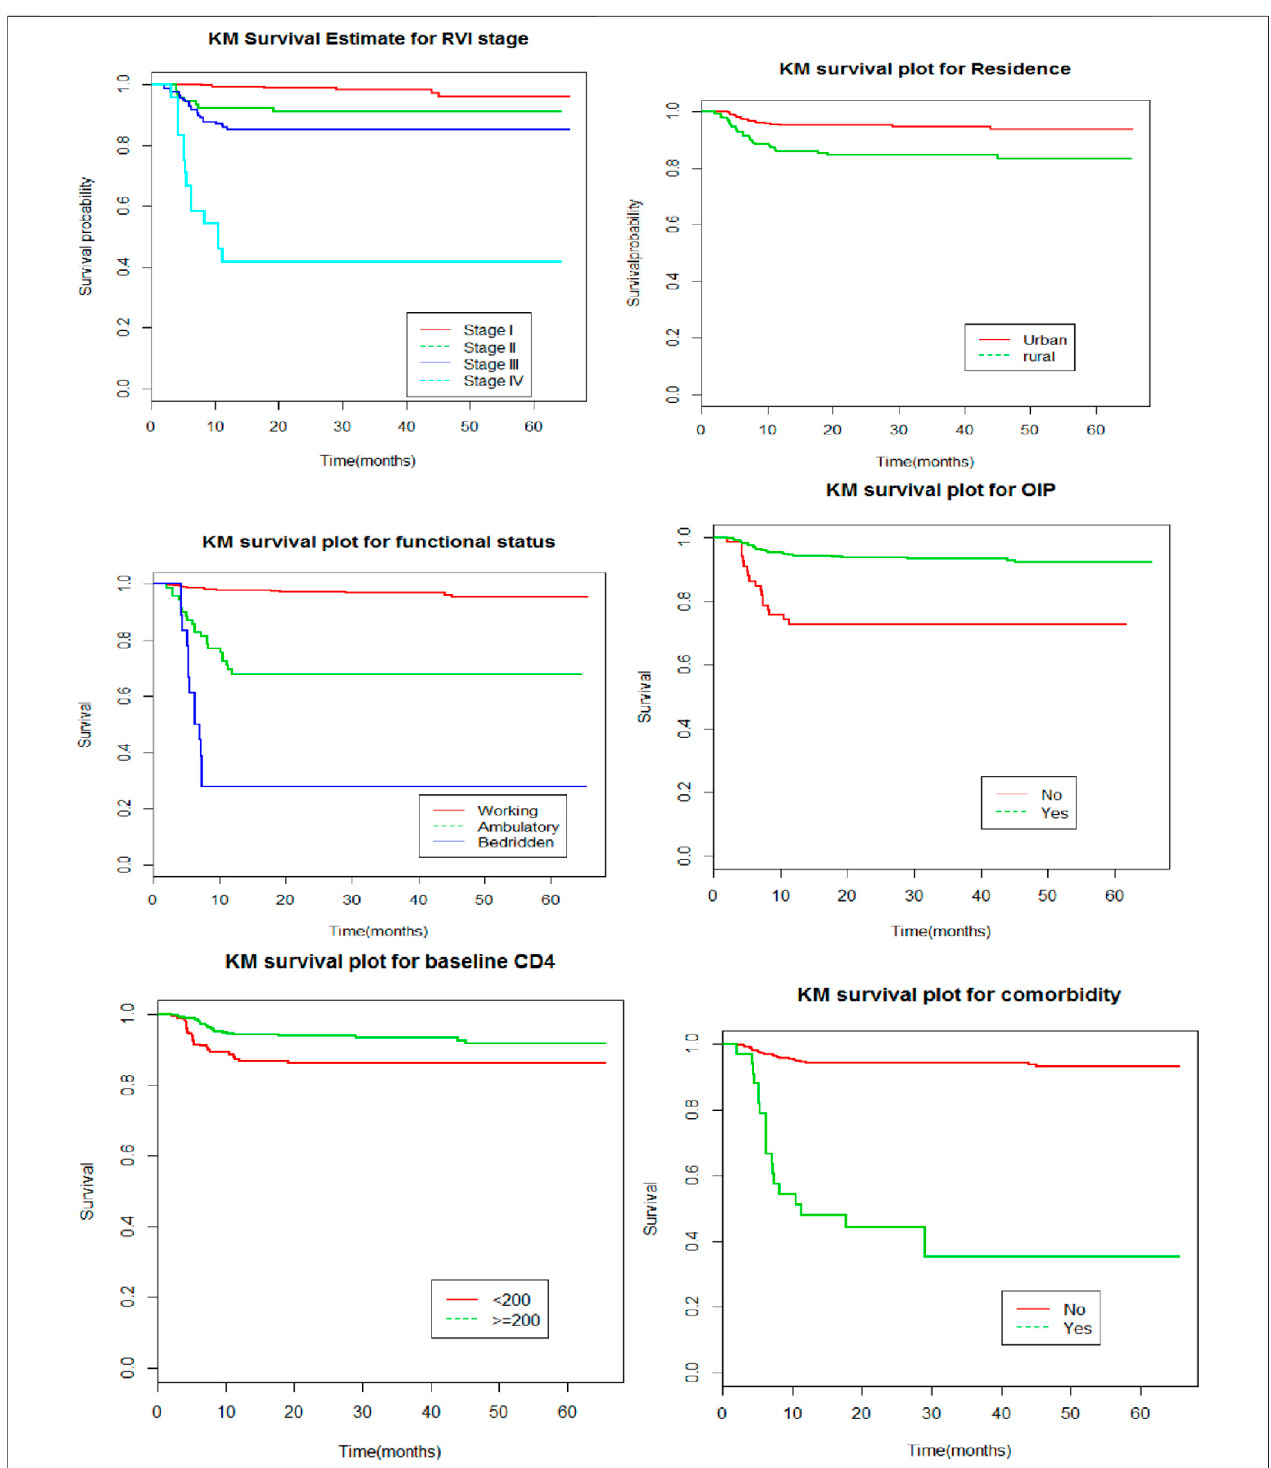
Figure S2 | Cumulative hazard plots for checking PHA.